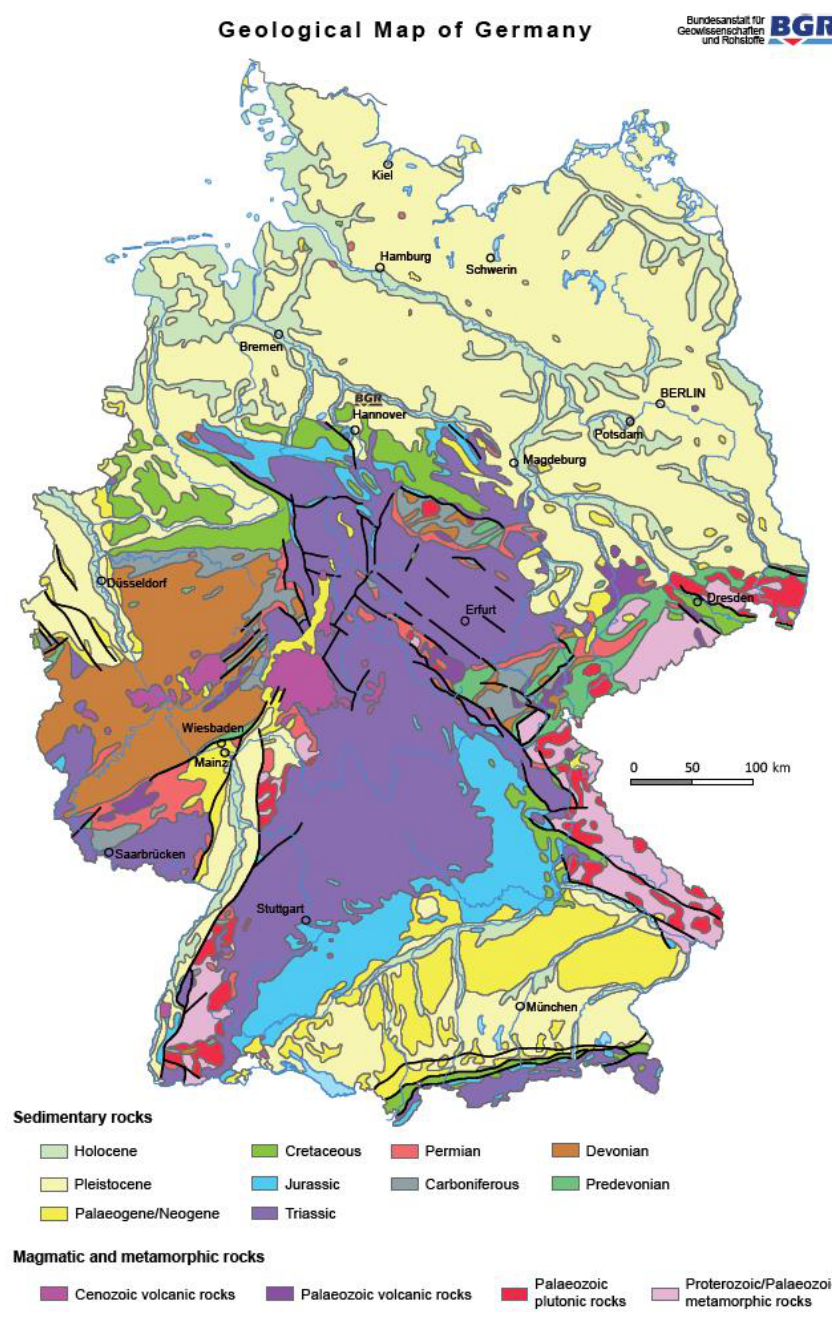
Figure Figure 3. Geology of the Federal Republic of Germany (Copyright: Bundesanstalt für Geowissen- schaften und Rohstoffe (BGR) (Federal Institute for Geosciences and Natural Resources), Hanno- ver).